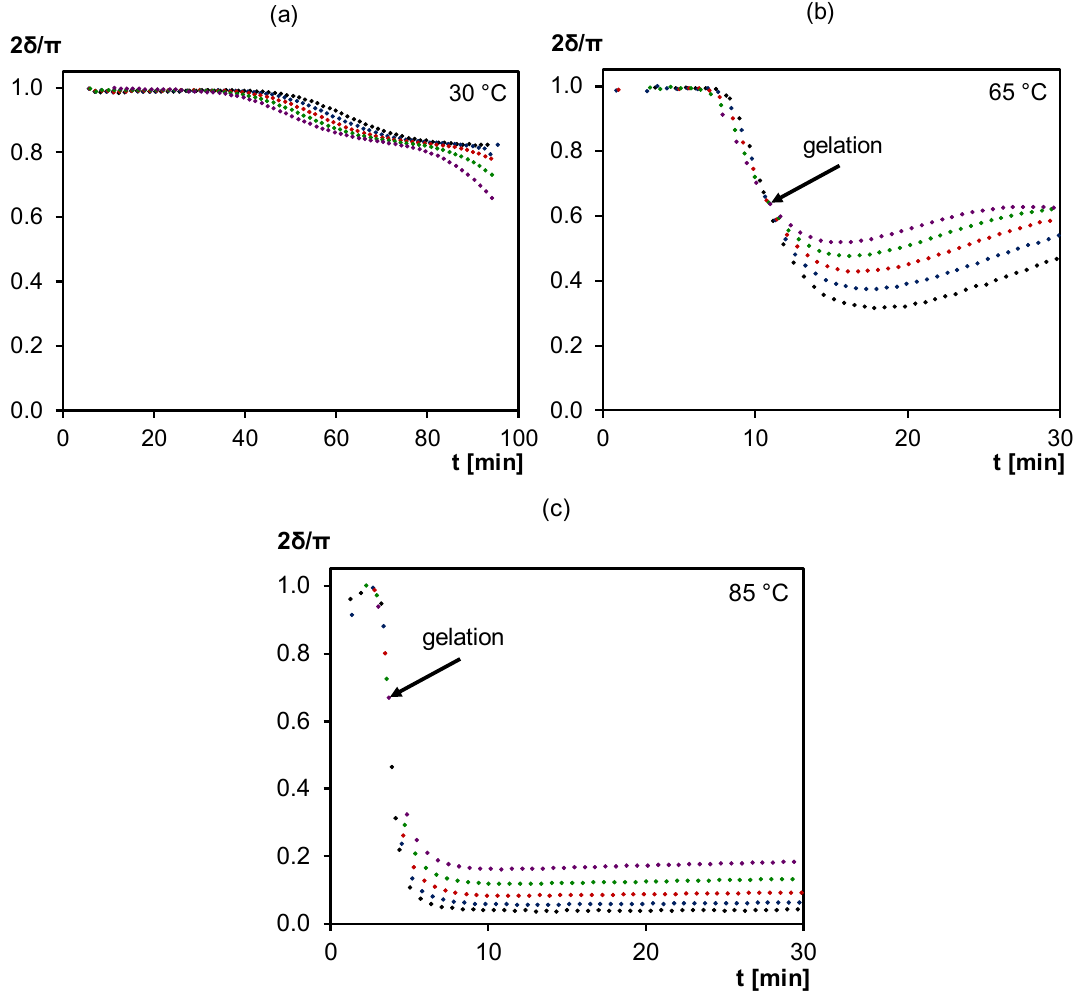
Figure 5. Normalized loss angle of dynamic rheometry during isothermal cure of 3M-3F630 at ( a ) 30 ◦ C, ( b ) 65 ◦ C, ( c ) 85 ◦ C. Black : 0.3 Hz; Blue : 0.6 Hz; Red : 1.0 Hz; Green : 1.8 Hz; Purple : 3.1 Hz.